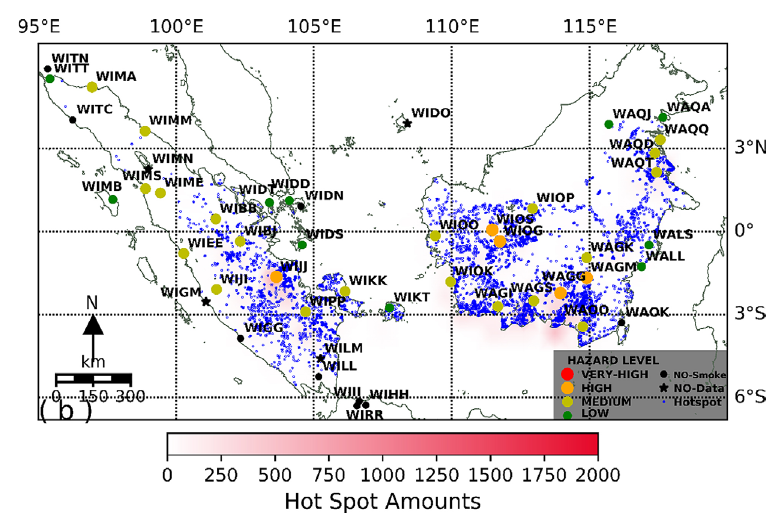
Fig. 4 b. The same as Fig. 4 a, for month August 2015.